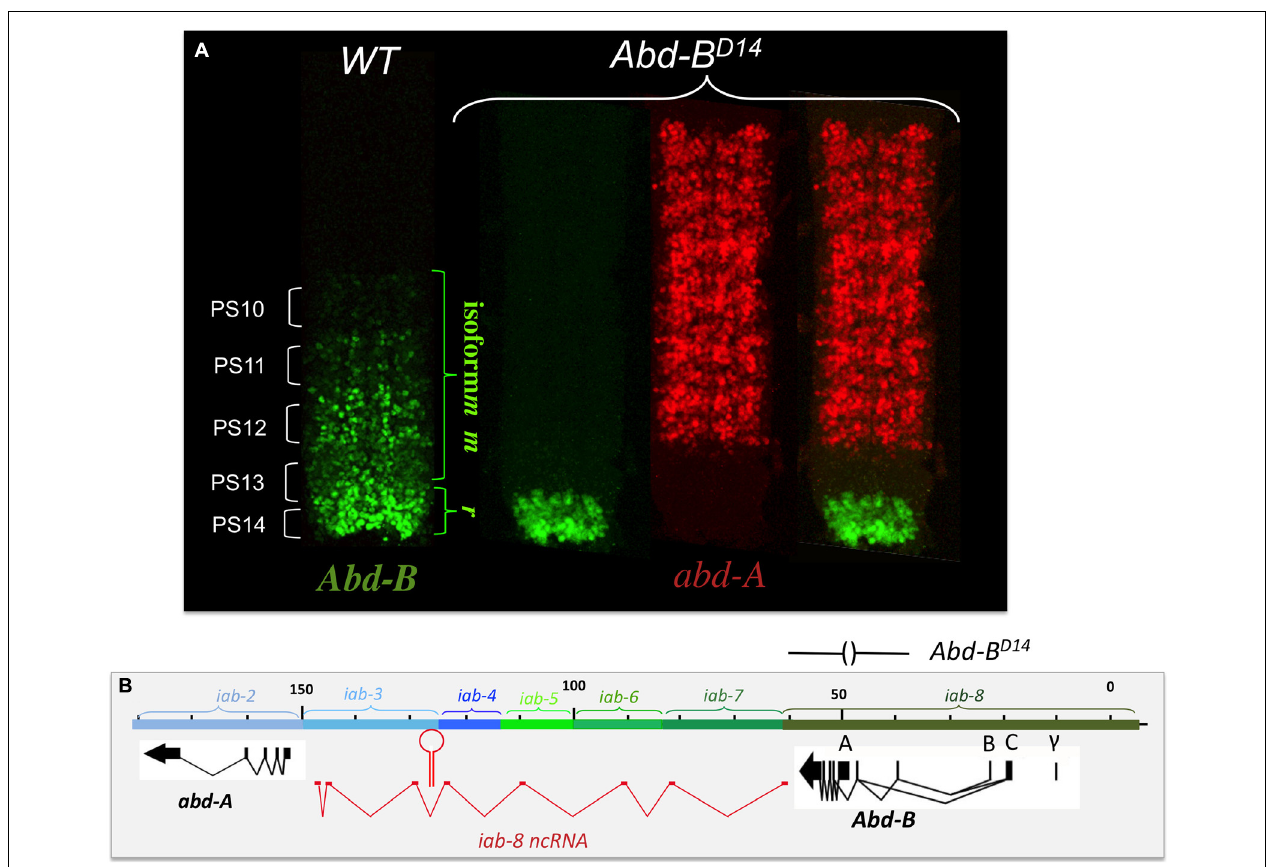
FIGURE 5 | abd-A is still repressed in the CNS of Abd-B D14 mutant embryo. Abd-B D 14 removes the promoter A of the Abd-B transcription unit (indicated above panel B ). As the A promoter is regulated by the iab-5 , iab-6 , iab-7 , and iab-8 regulatory domains, there is no Abd-B expression in PS10 to PS13 (see panel A ). In